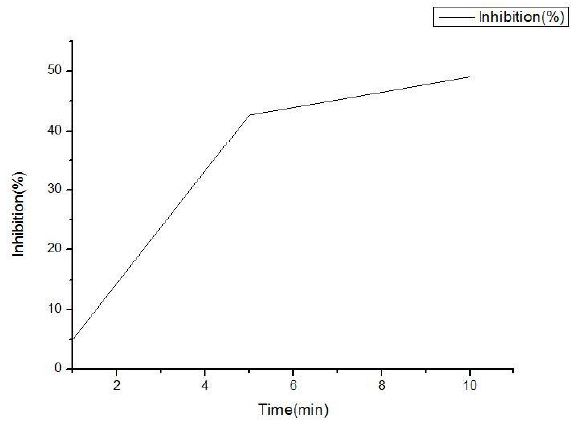
Figure 11. The inhibition ratio variation during the incubation time after adding our target organ- ophosphorus isocarbophos